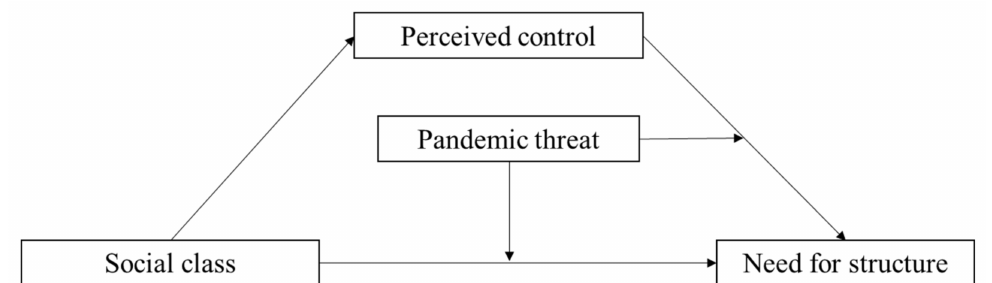
Figure 1. Hypothesized moderated mediating